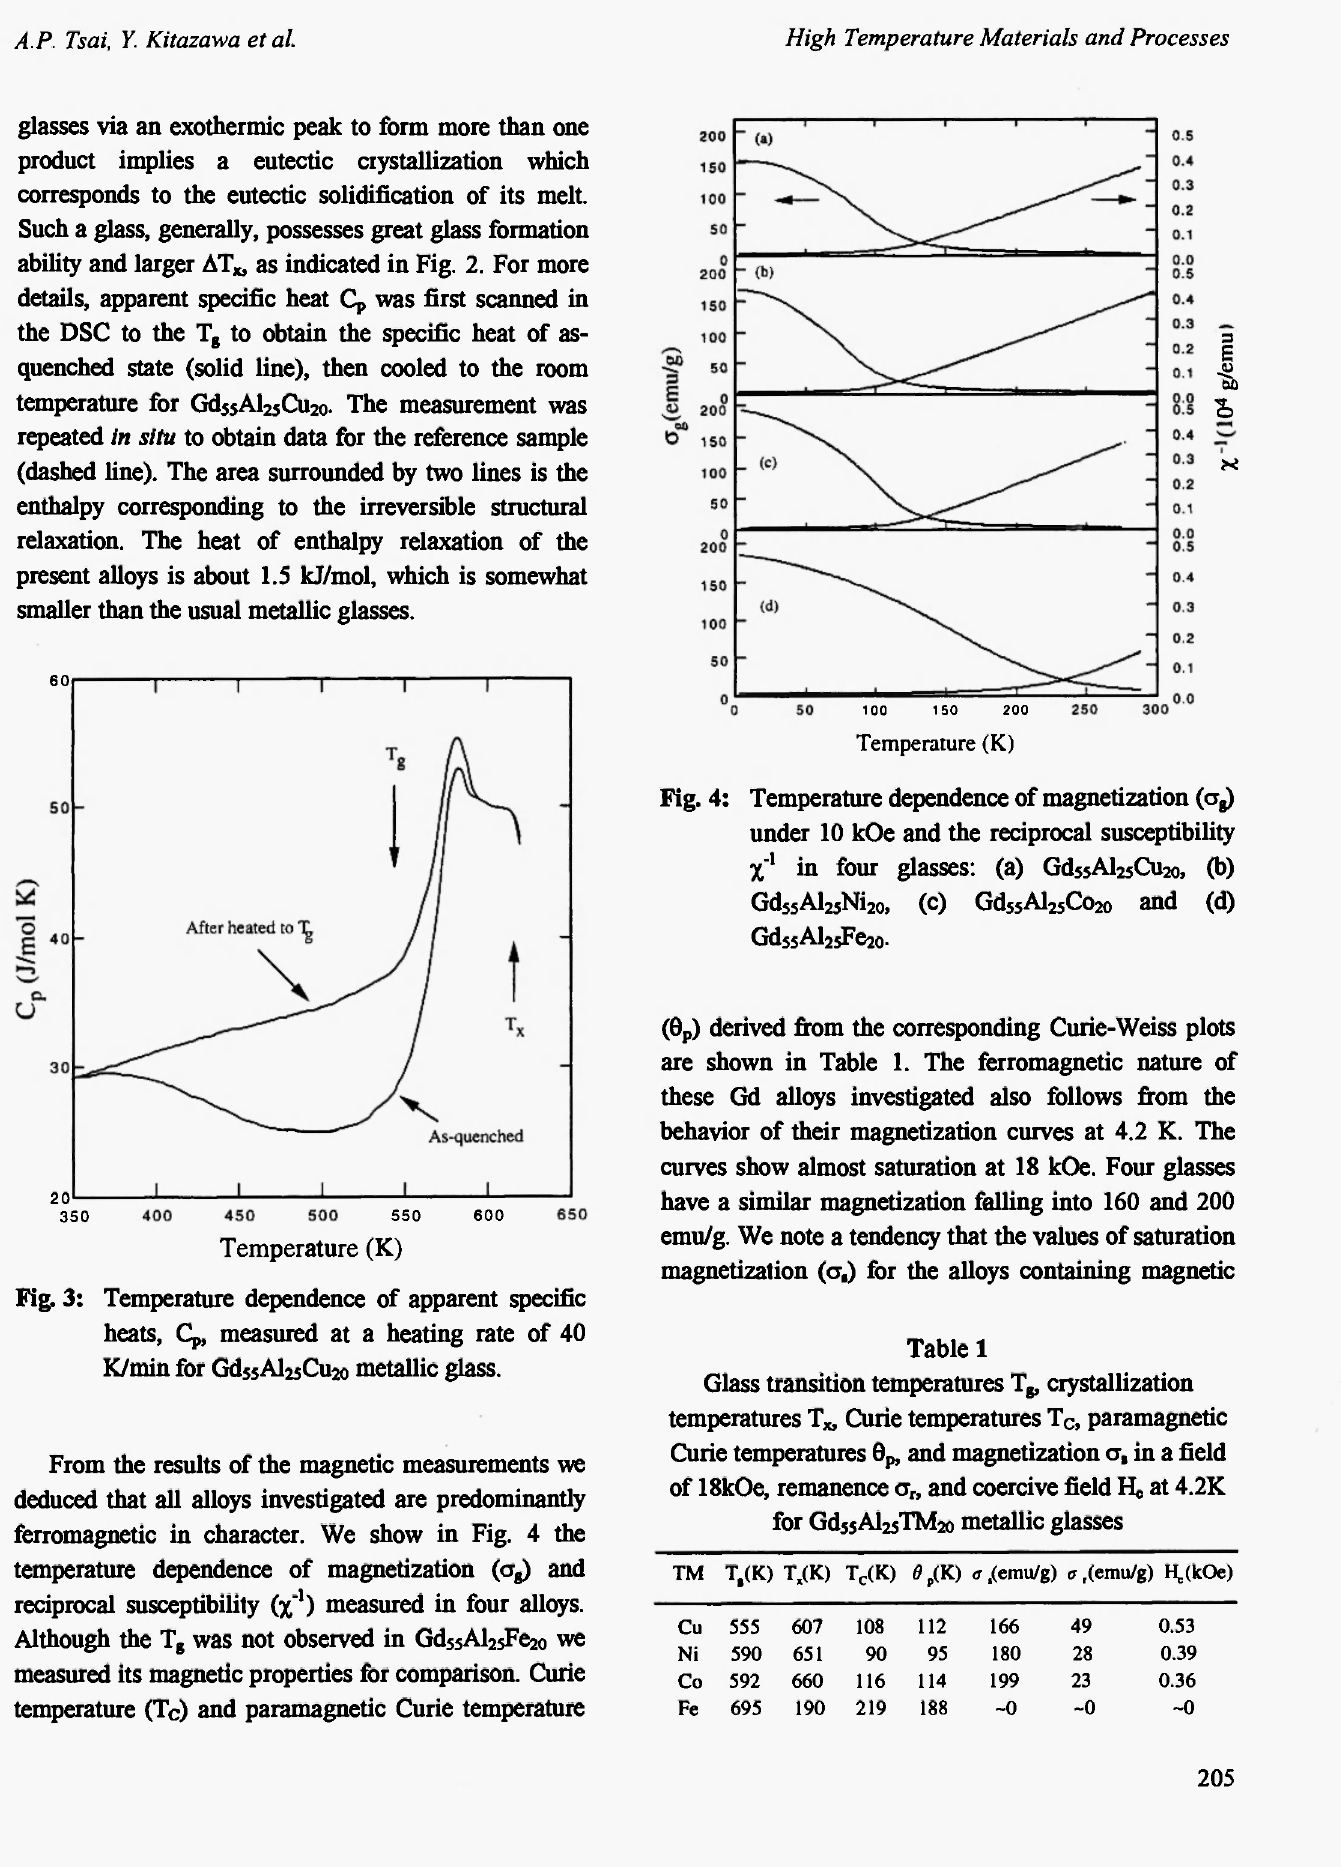
Fig. 3: Temperature dependence of apparent specific heats, Cp, measured at a heating rate of 40 K/min for GdssAl^Cuao metallic glass.